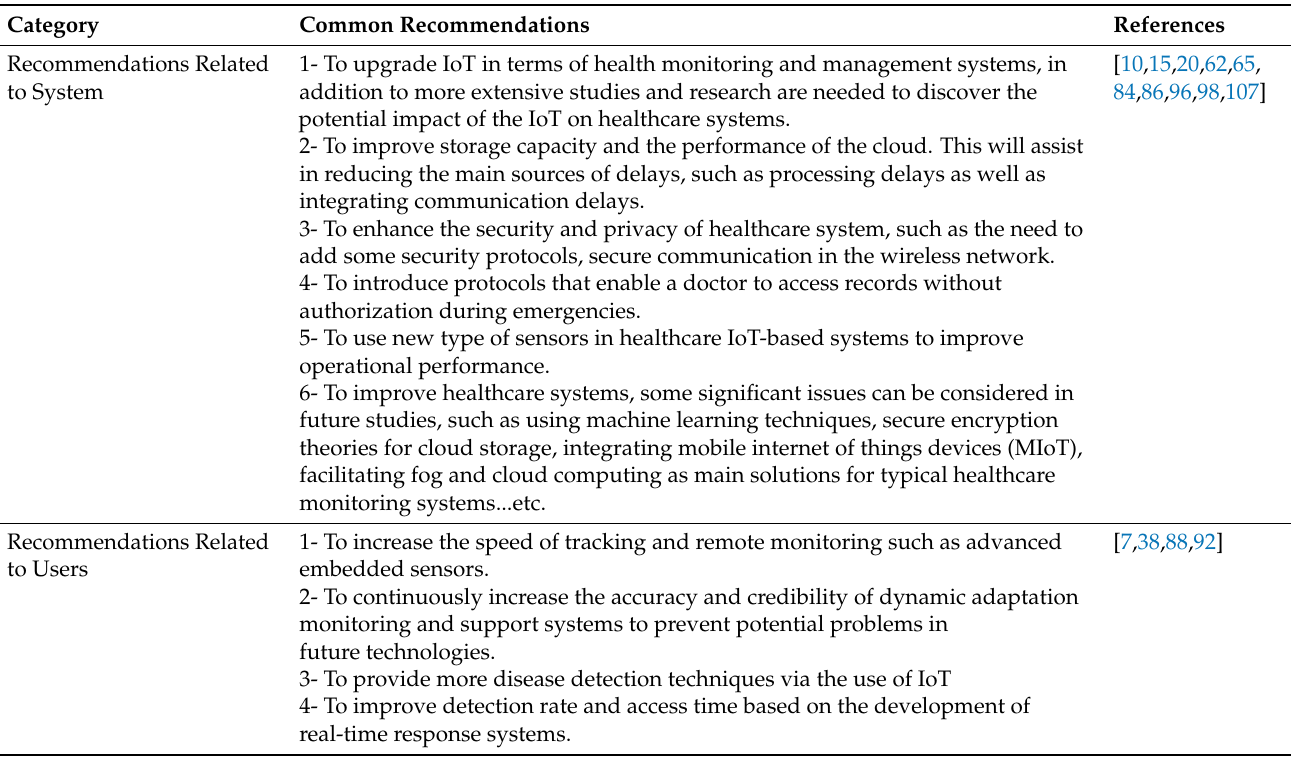
Table 4. Summary of common